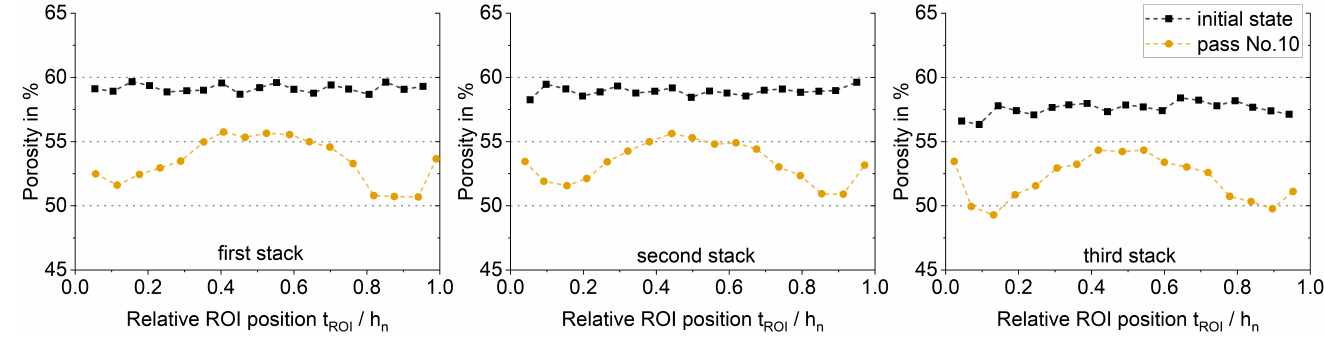
Figure A3. Series II: 5-0.15-10 ( l d / h m ≈ 0.5 − 0.75): Porosity change over relative sample depth (0=upper surface; 0.5= mid-section of sample; 1=lower surface) due to rolling for first, second and third